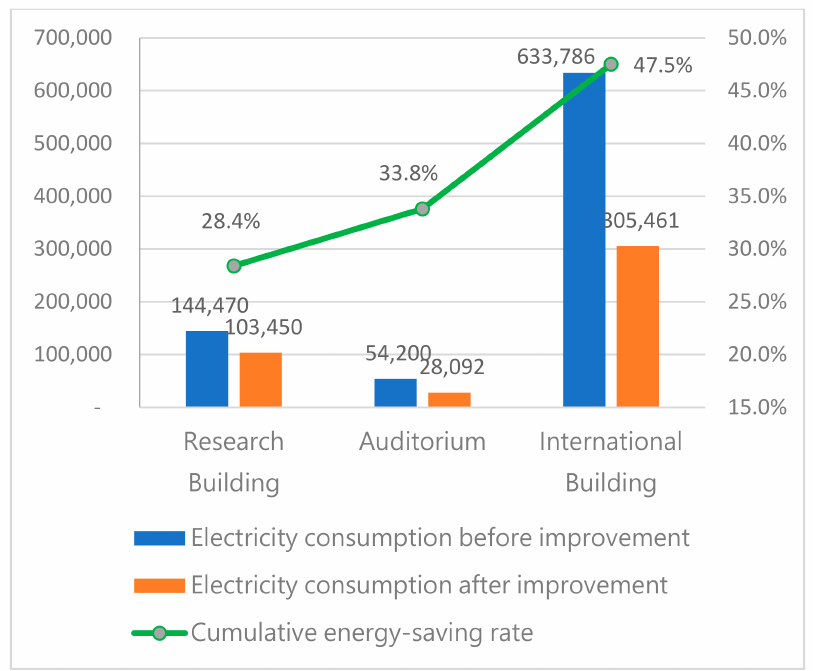
Figure 6. Electricity consumption before and after air-conditioning improvement, and cumulative energy-saving